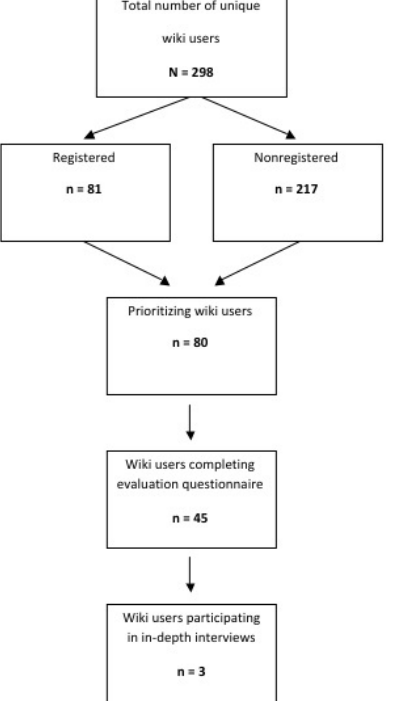
Figure 4. Flow of wiki participants through the